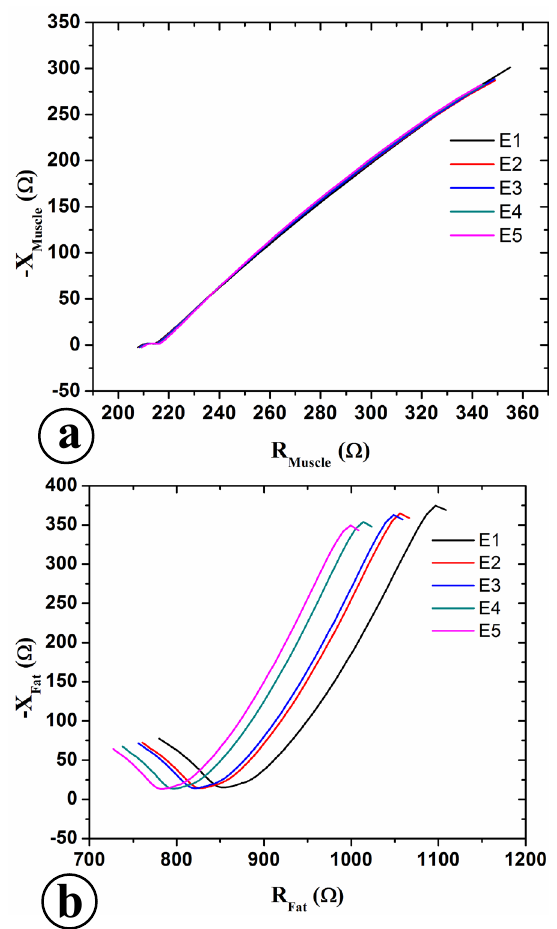
Figure-8: Nyquist plots tissue samples (a) muscle Paste, (b)